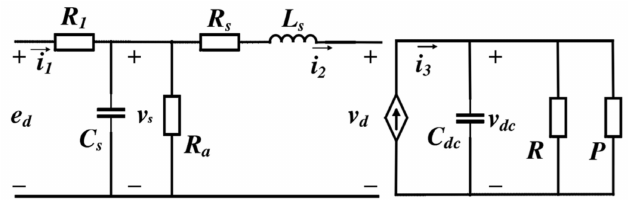
Figure 9. The equivalent model of AC/DC Hybrid Microgrids in